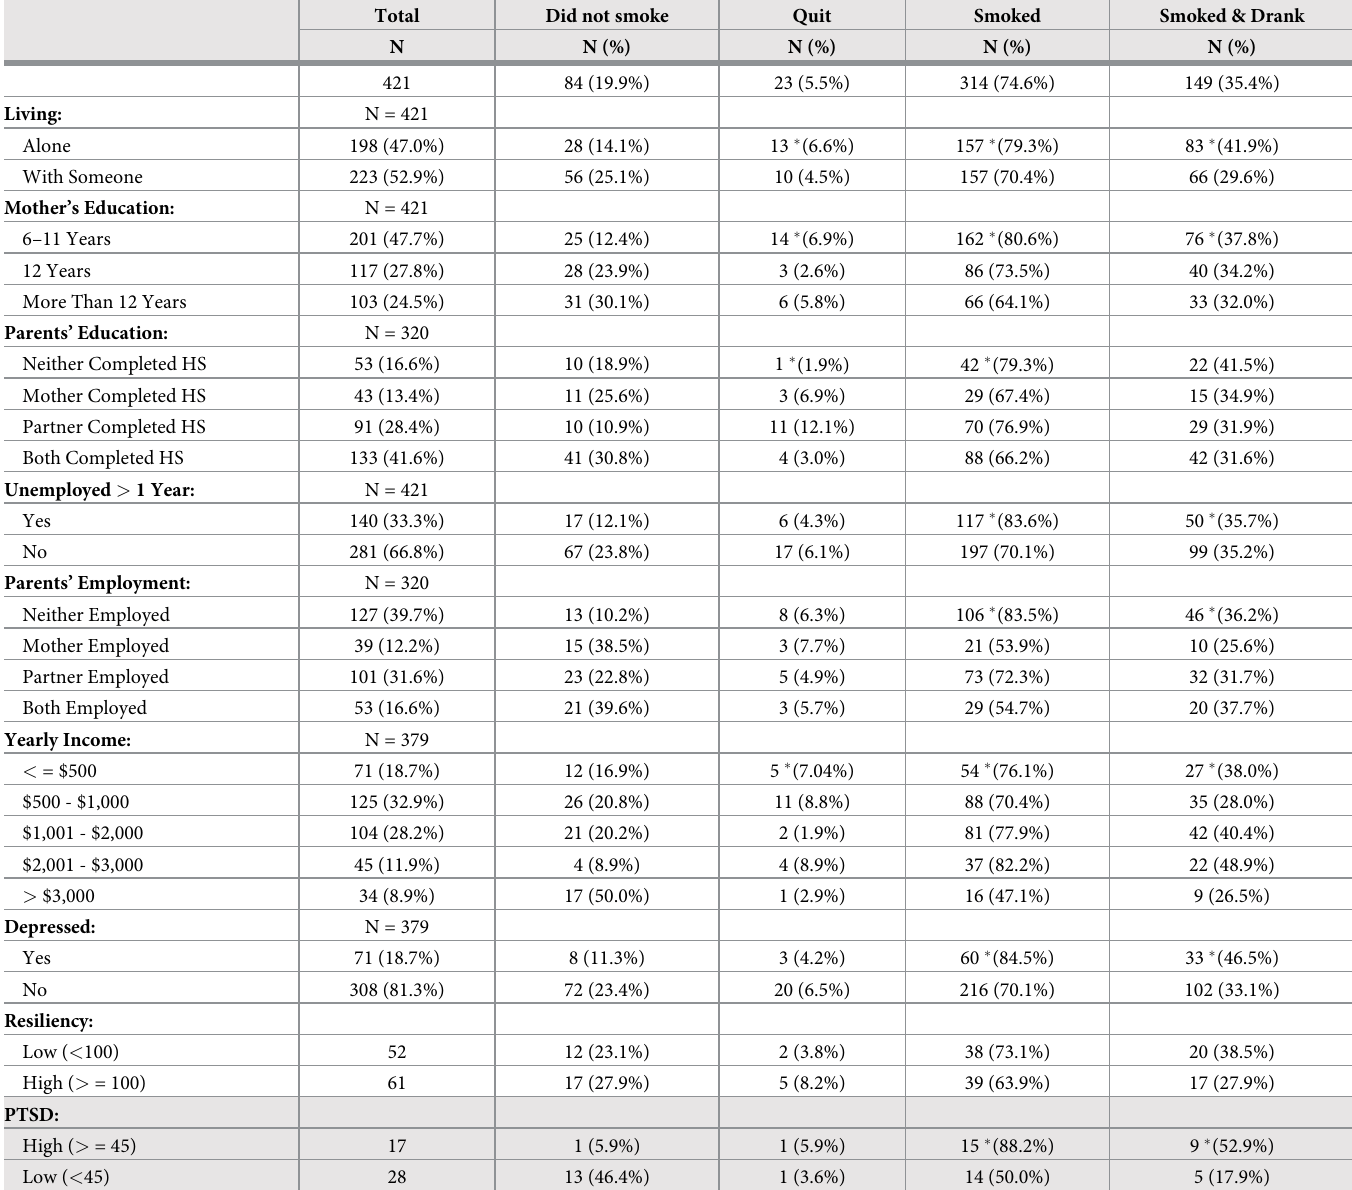
Table 1. Prevalence of smoking and drinking during pregnancy associated with mother’s